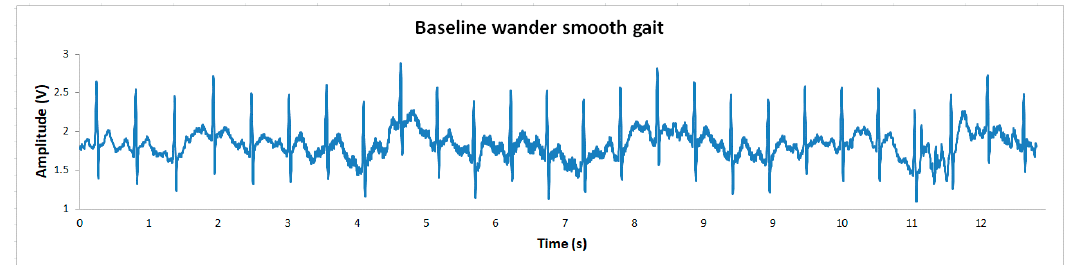
Figure 14. Baseline wander during smooth gate. I-Lead ECG signal from human volunteer to check the baseline wander during a smooth gait of approximately 18 m/min. The signal was transmitted by Bluetooth at 115,200 baud rate and a sampling rate of 500 Hz.